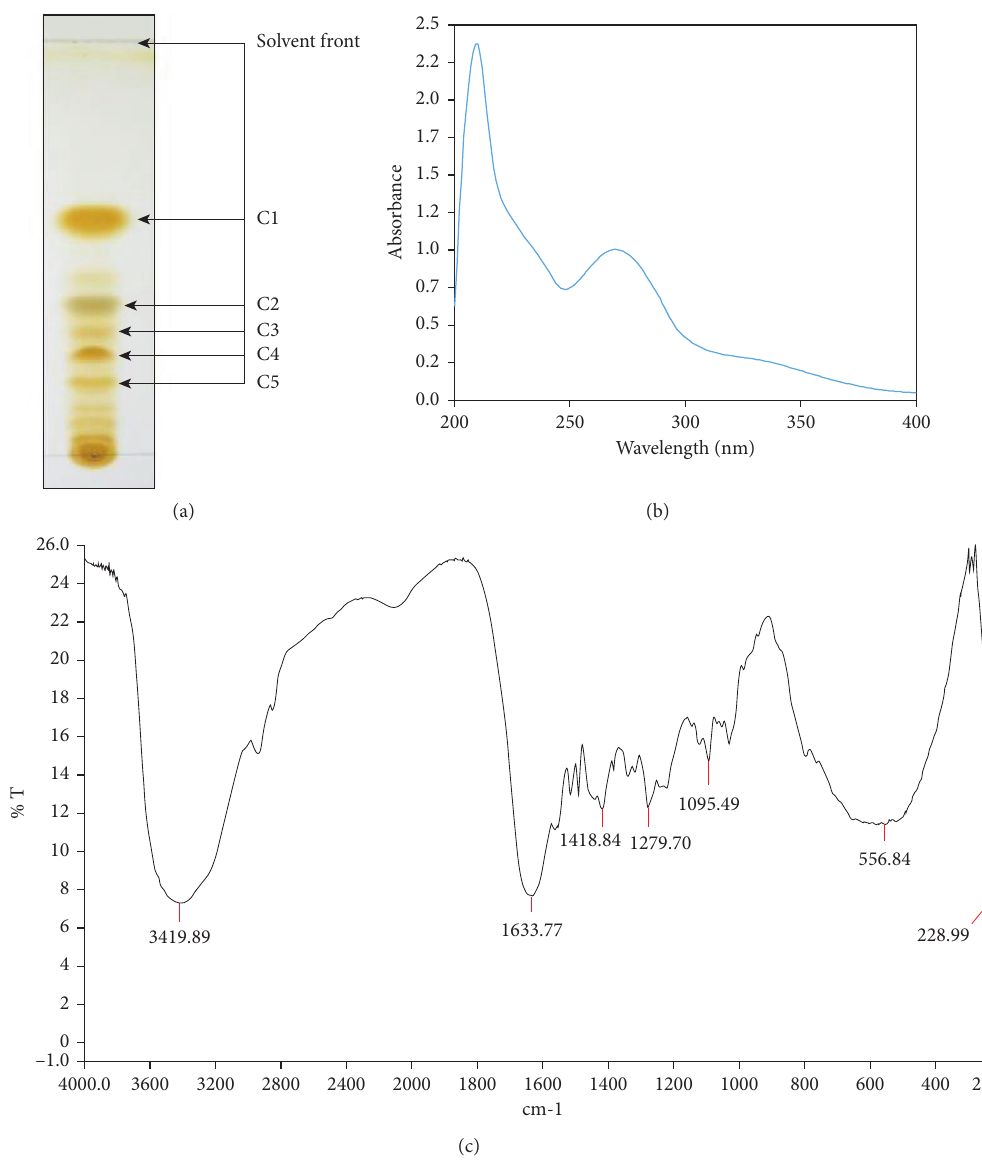
Figure 7: Chromatographic and spectroscopic characterization of the CHF. (a) Thin layer chromatography (TLC) profile, (b) UV spectrum, and (c) IR spectrum of